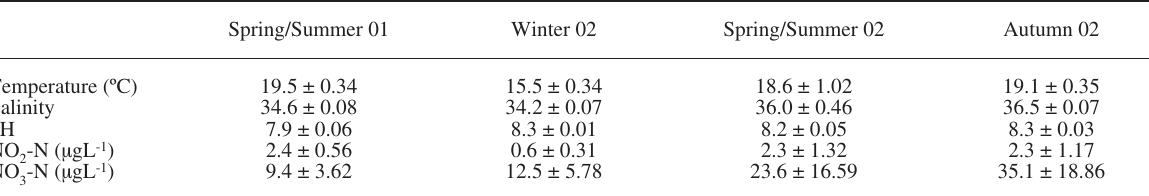
-n) and nitrate (no -n) means ± standard deviation for the entire depth gradient, for the 2 3 main seasons: spring/summer 01 and 02, winter 02 and autumn 02.